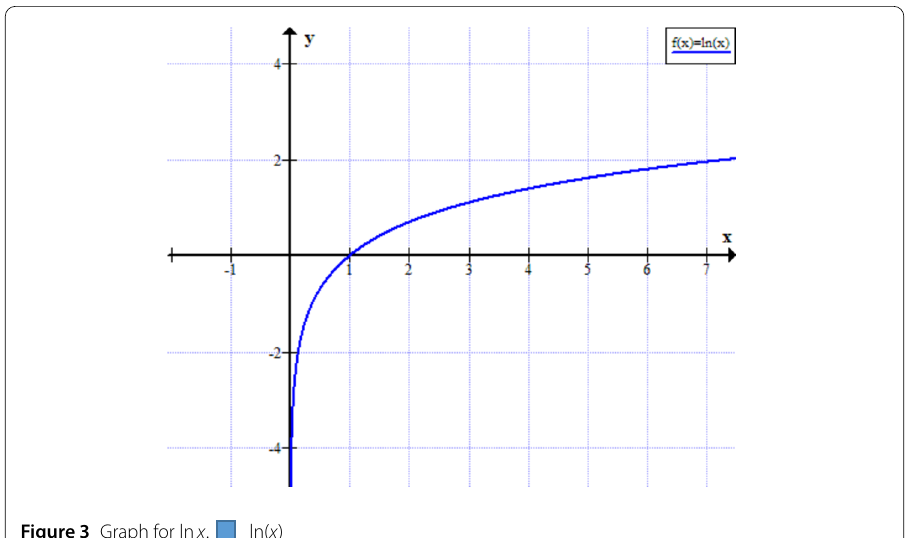
Figure 3 Graph for ln x . (cid:3)(cid:3)(cid:3)(cid:3) ln( x